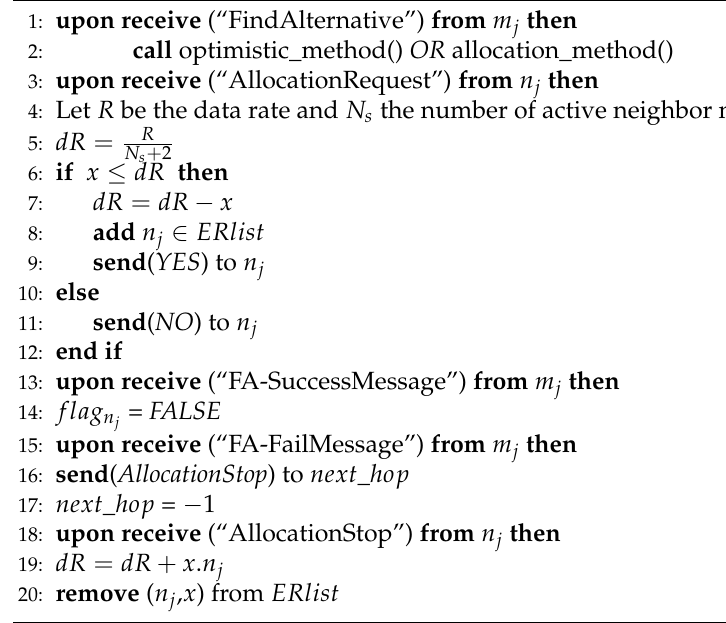
Algorithm 7 Algorithm for node n